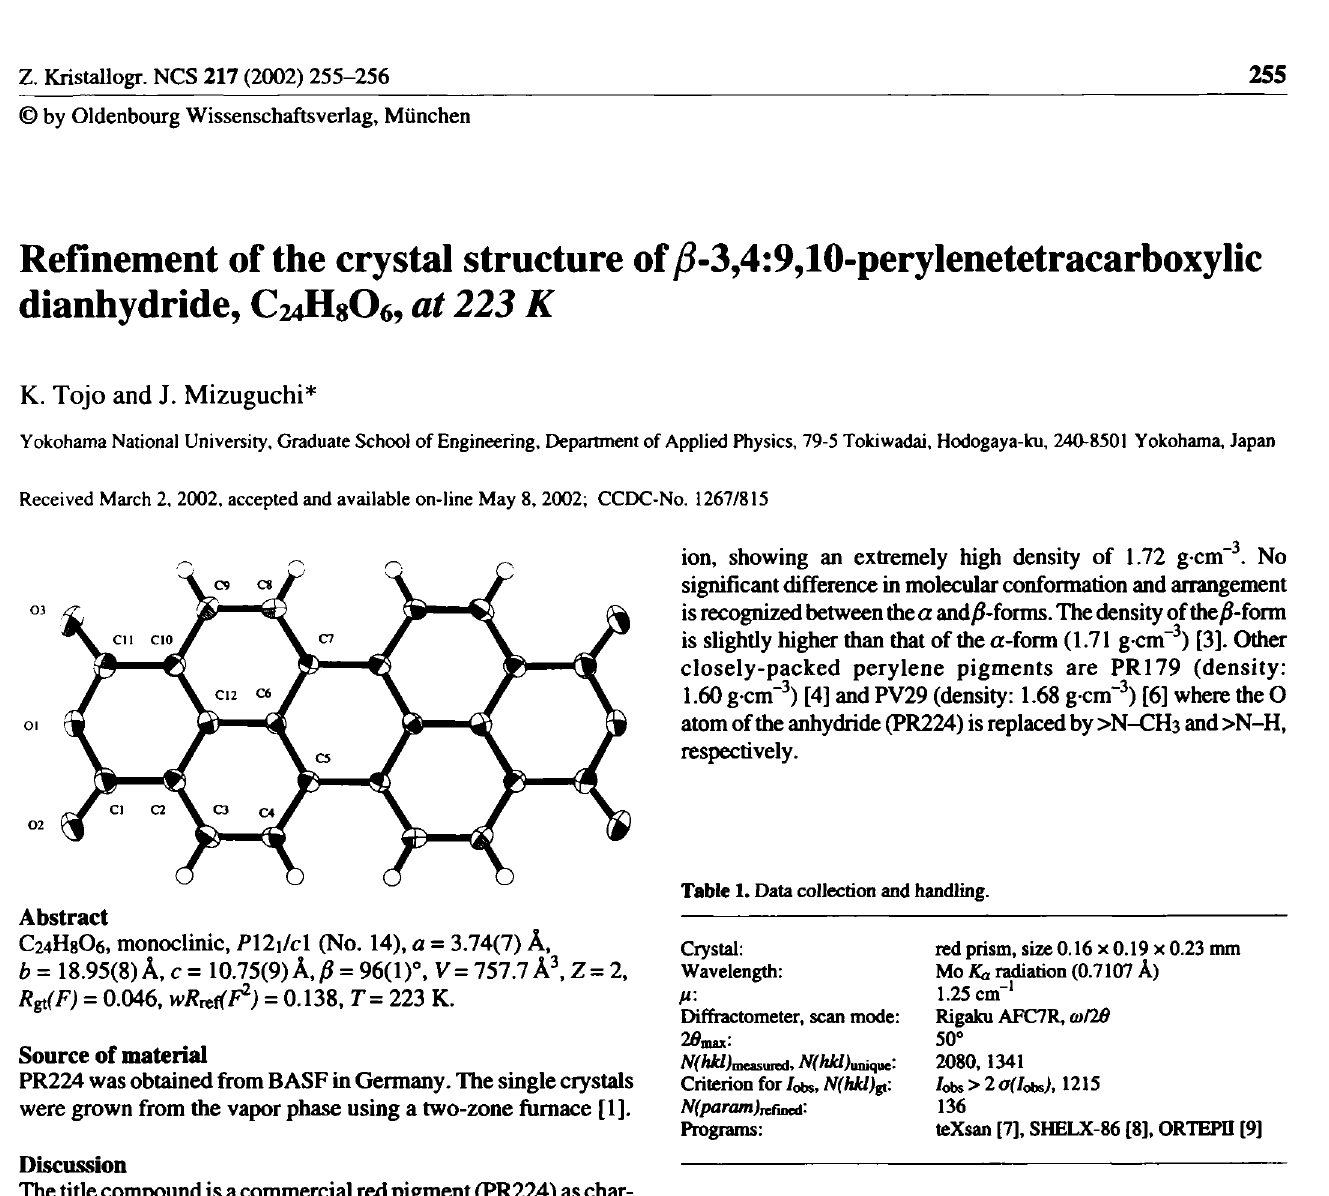
Table 2. Atomic coordinates and displacement parameters (in Â 2 ).